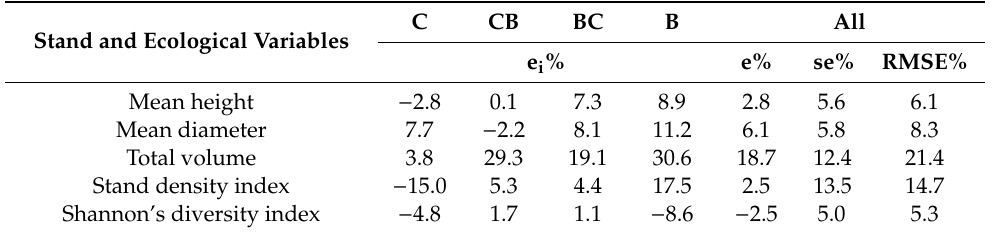
Table 5. Relative di ff erences between ALS-estimated and ground-measured data using the raster-based method. Stand and Ecological Variables